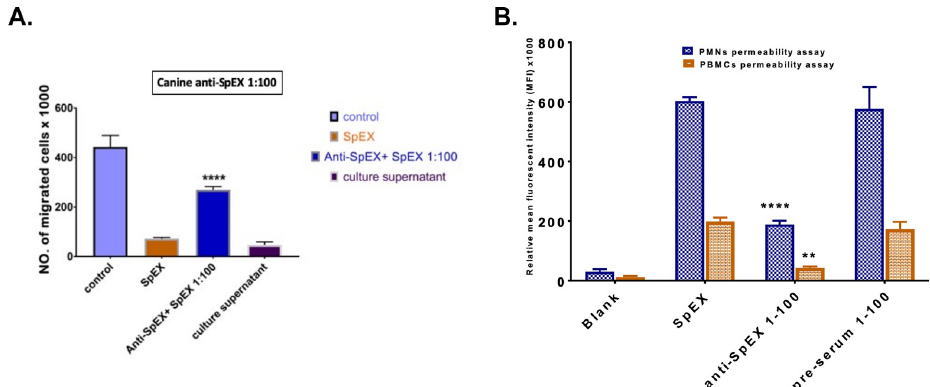
Fig 9. Canine anti-SpEX-M neutralized SpEX. a. Canine anti-SpEX, collected after three injections, at a dilution of 1:100 in PBS (pH 7.2), preincubated with recombinant SpEX, significantly diminished the chemotaxis inhibition of SpEX with P < 0.0001 ���� . b. Pre-incubation of canine anti-SpEX diluted 1:100 with SpEX resulted in a significant reduction in MFI in permeability assays as compared with that of SpEX treatment alone. There was no significant difference between SpEX and SpEX treated with pre-serum. The MFI of SpEX pre-incubated with anti-SpEX 1:100 relative to SpEX was significantly lower in PMN (P < 0.0001 ���� ) and monocyte (P = 0.012 �� ) permeability assays. The values calculated were based on average values from three independent experiments ( � P < 0.05 was considered significant).